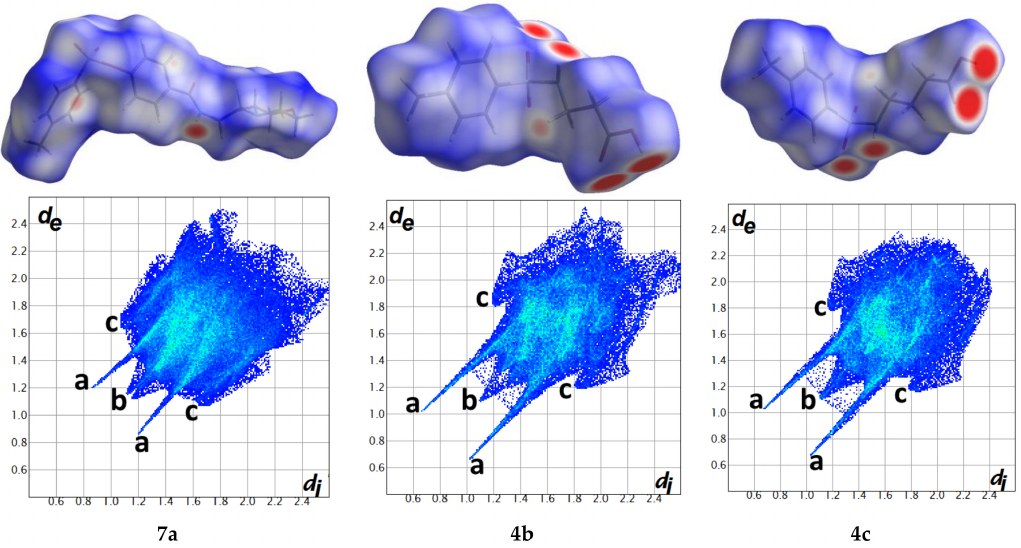
Figure 5. The d norm surfaces ( upper ) and fingerprint plots ( lower ) of the studied compounds. The Sharpe spikes refer to the strong O . . . H hydrogen bonding interactions (a), while the broad peaks refer to the weak hydrophobic C . . . H (b) and H . . . H (c) contacts.